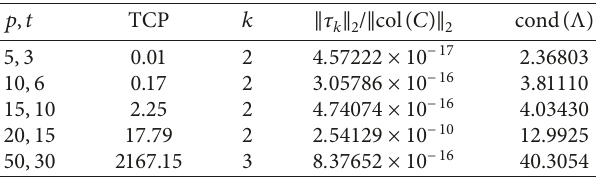
Table 2: TCP, iteration number k , and the relative errors obtained by predictor-corrector algorithm for Example 2.